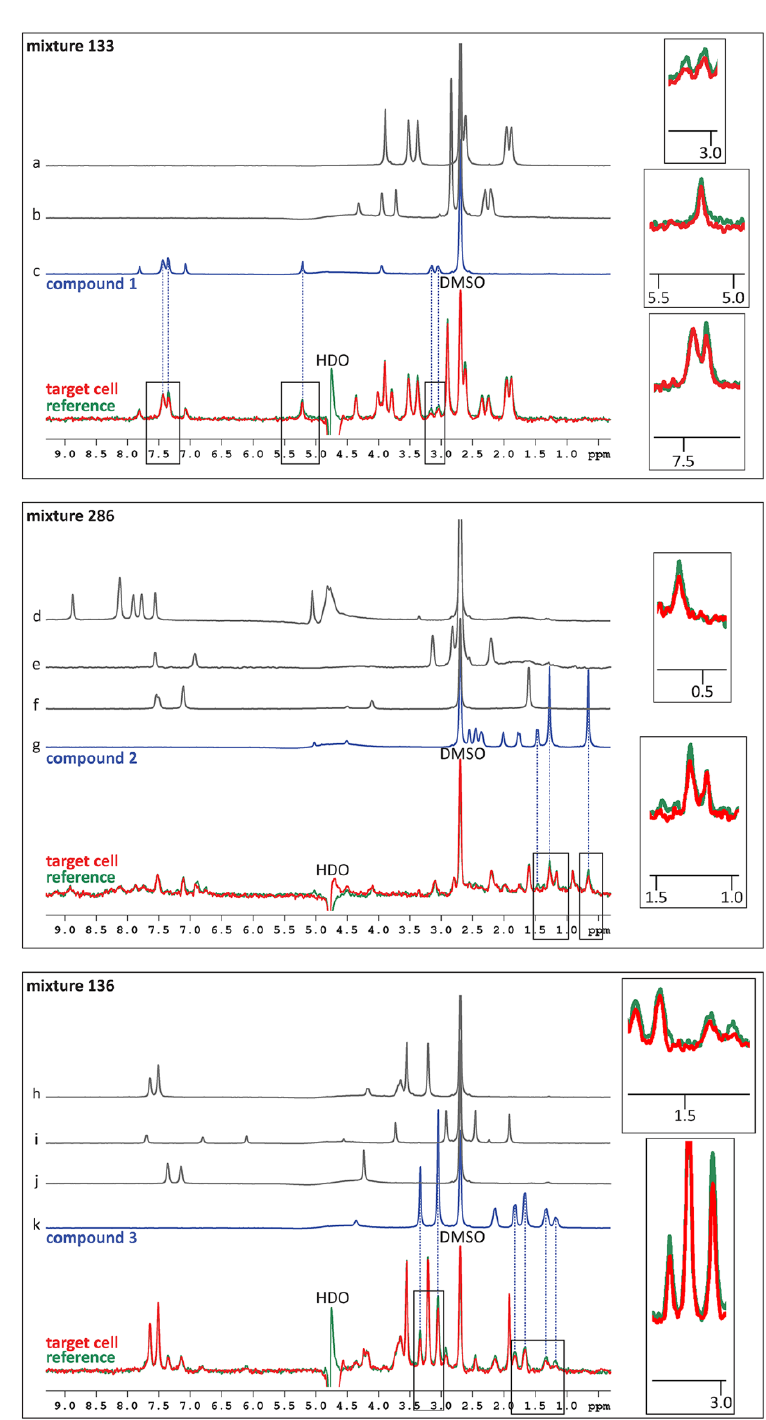
Figure 1. TINS spectra showing the mixtures containing compounds 1, 2 and 3. The blue traces show the 1 H-NMR spectra of the compounds, the grey traces show the 1 H-NMR spectra of the other compounds present in the mixtures. None of these other compounds were identified as a hit, as they gave T / R ratios between 0.930–1.045. Compounds 1, 2 and 3 resulted in T / R ratios of 0.839, 0.789 and 0.806, respectively. The red trace represents the spectrum obtained from the target cell, the green trace shows the spectrum obtained from the reference cell. The background signals caused by the solvent are annotated with DMSO and HDO. Hits were identified by calculating the ratio of the red (target) spectrum compared to the green (reference) spectrum: interaction with FtsQ p causes a decrease in peak height in the target cell compared to the reference cell.